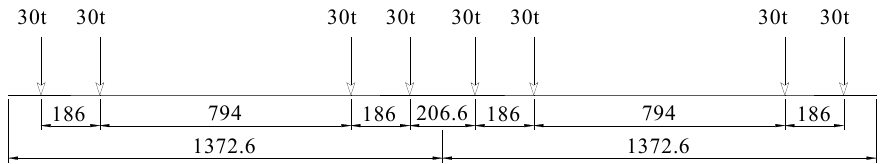
Figure 12. The calculated results with and without NPSS. ( a ) Midspan deflection; ( b ) midspan bending moment; ( c ) support force.